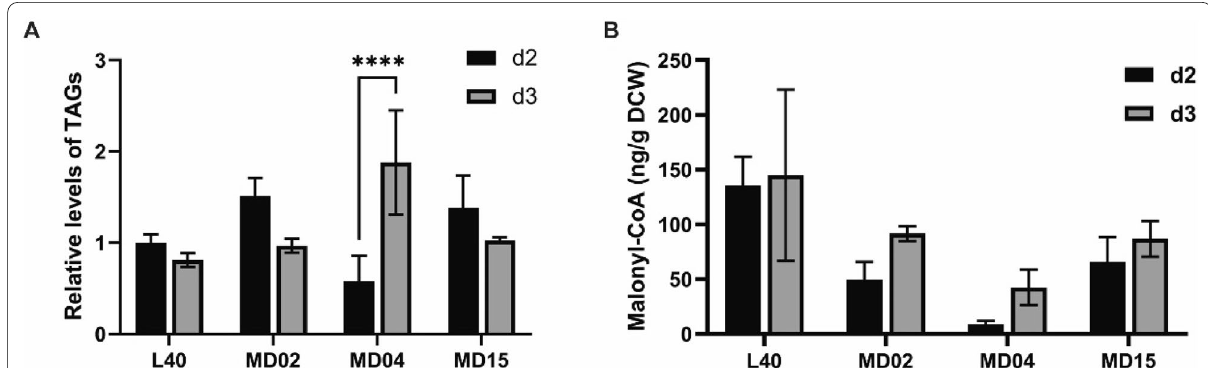
Fig. 8 Analysis of intracellular TAG and M-CoA in PKS-disrupted mutants. A Relative levels of intracellular TAG pool of strain MD02, MD04, MD15 on day 2 and day 3 of fermentation. Data were normalized based on the TAG pool of strain L40 at day 2 of fermentation. The values are means SD of ± three independent experiments. Significant differences were analyzed by two-way ANOVA, and **** p < 0.0001. B Concentrations of the intracellular M-CoA in gene cluster-disrupted mutants. The values are means SD of three independent experiments. L40 the parent strain. MD02 mutant with ± T1PKS-15 deletion. MD04 mutant with T1PKS-18 deletion. MD15 mutant with T1PKS-15 and T1PKS/NRPS-5 deletion